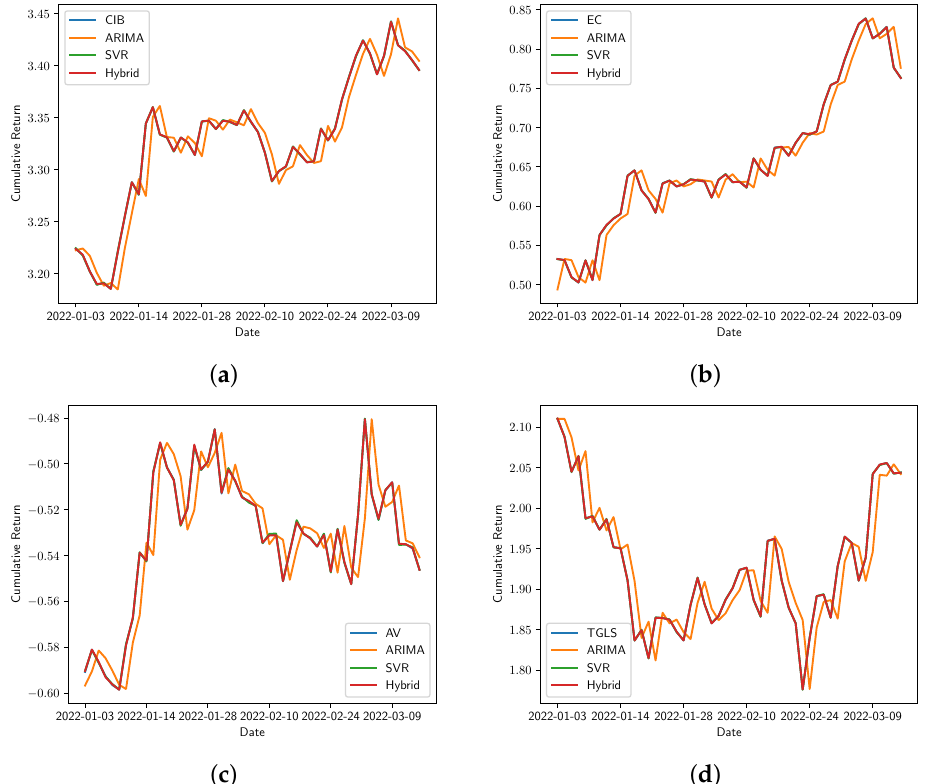
Figure 10. Real vs. the ARIMA, SVR, and Hybrid models’ adjustment for cumulative returns. ( a ) Bancolombia, ( b ) Ecopetrol, ( c ) Grupo AVAL, and ( d ) Tecnoglass. The real-time series is repre- sented by the stock symbol and its forecasts by the name of the corresponding